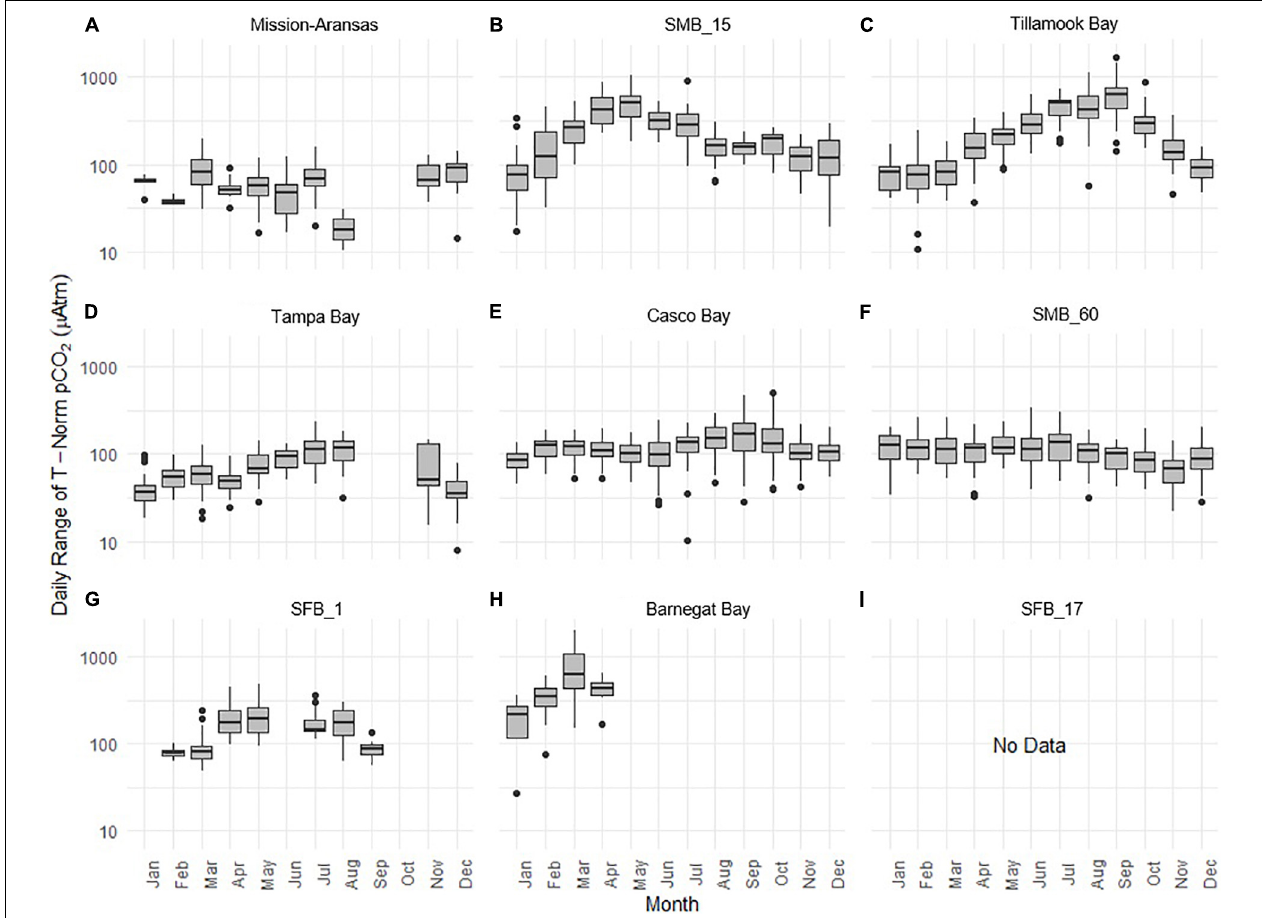
FIGURE 13 | Box plots highlighting diel range of partial pressure of carbon dioxide ( p CO 2 ) p CO 2 bio / hydro . The water bodies are arranged from lowest median p CO 2 to highest median p CO 2 : (A) Mission-Aransas Estuary; (B) Santa Monica Bay (SMB_15); (C) Tillamook Bay; (D) Tampa Bay; (E) Casco Bay; (F) Santa Monica Bay (SMB_60); (G) San Francisco Bay (SFB_1); (H) Barnegat Bay; (I) San Francisco Bay (SFB_17). Data binned by month. Y -axis is log-10